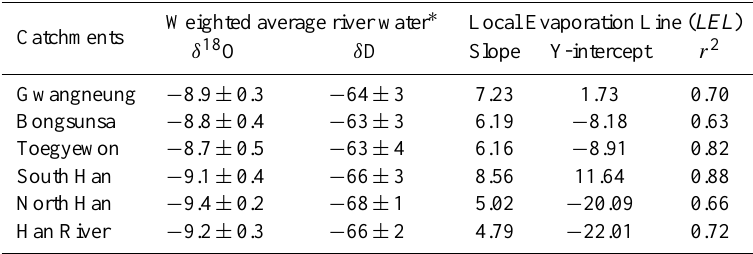
Table 2. Discharge weighted mean isotope compositions of the rivers, and the slopes and intercepts of Local Evaporation Line ( LEL ) for the period from 2005 to 2006. Weighted average river water ∗ Local Evaporation Line ( LEL ) Catchments δ 18 O δ D Slope